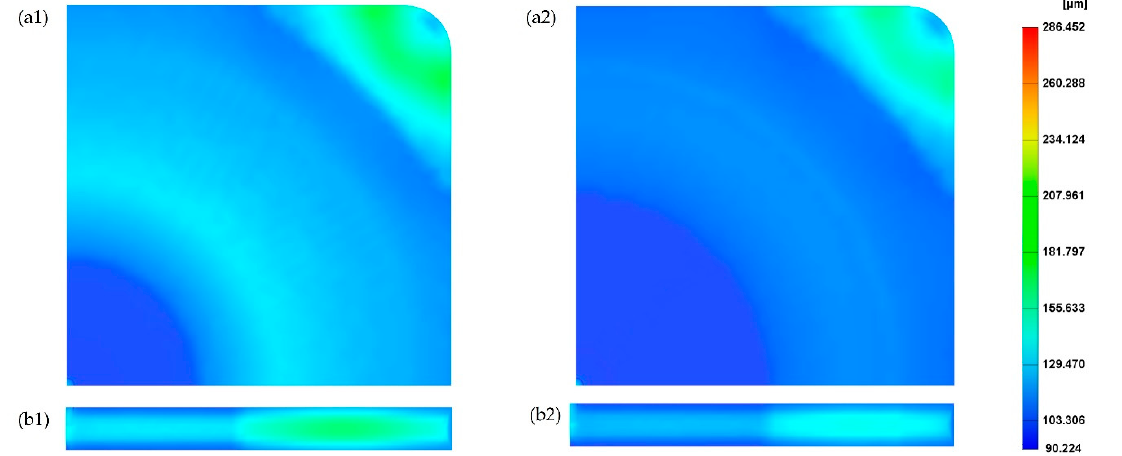
Figure 19. The cell distribution at the surface and cross-section of the MuCell ® part considering a flow rate of 295.5 cm 3 /s ( a1 , b1 ) and 689.5 cm 3 /s ( a2 , b2 ).